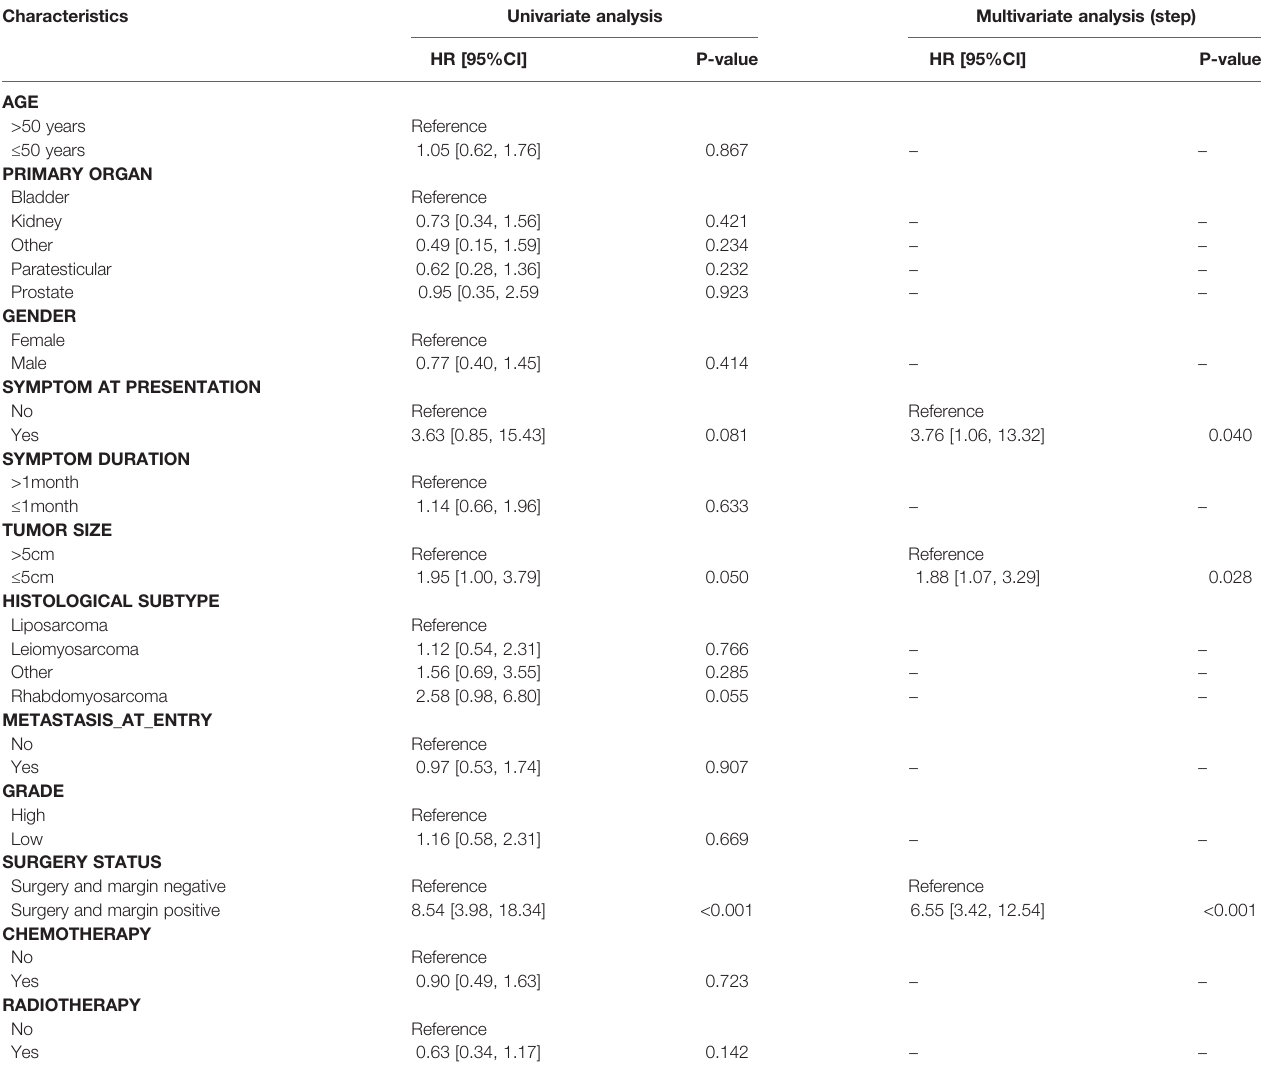
TABLE 3 | Univariate and multivariate analyses of recurrence-free survival in the present study.